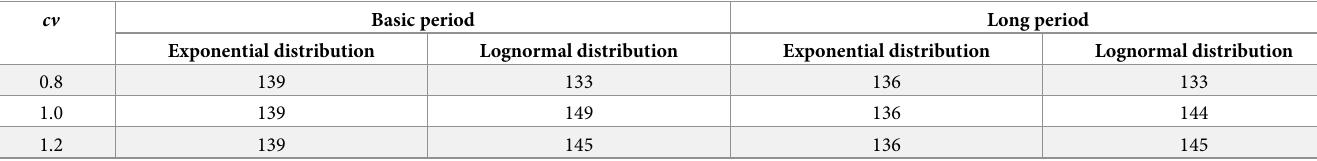
Table 7. Subsidy variation between three mechanisms.